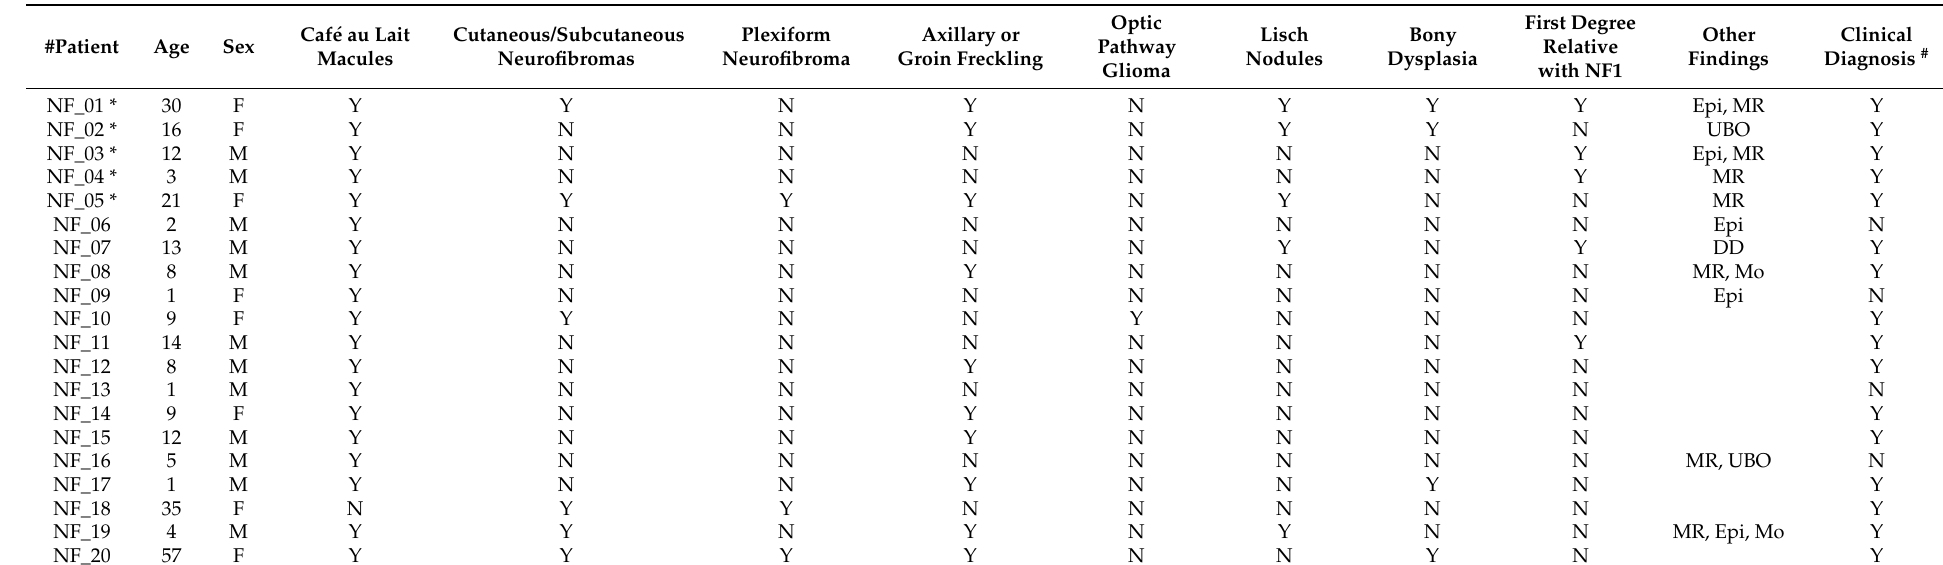
Table 2. Summary of the clinical features of the